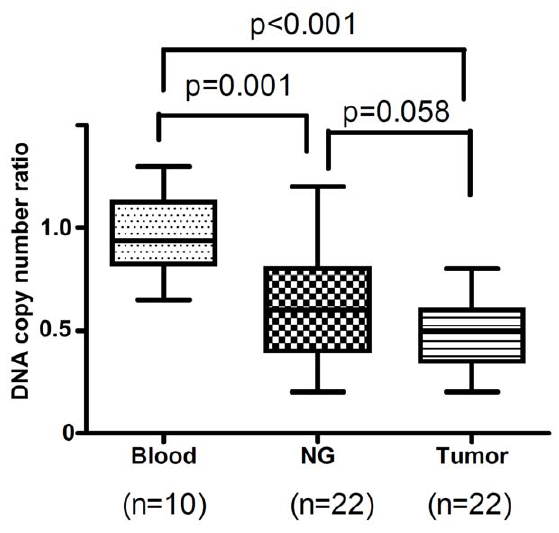
Figure 5. GPX3 copy number loss in gastric cancers. GPX3 copy number was determined by qPCR and normalized to both beta-actin and GAPDH of the same samples. The results were then compared to 10 blood DNA samples from normal individuals in which GPX3 copy number was assumed to be 2.0 (copy number ratio equals to 1.0 in Table 1). Loss of GPX3 copy number was detected in both gastric cancer